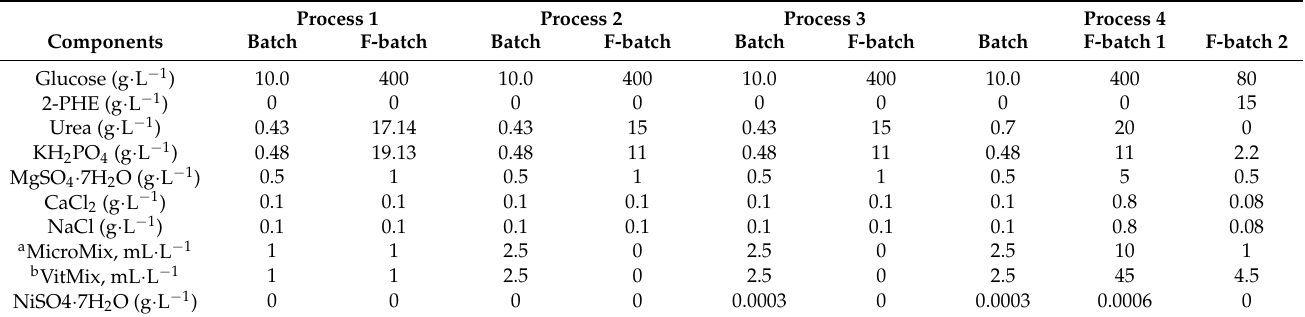
Table 3. Cultivation medium and feeding solution compositions.